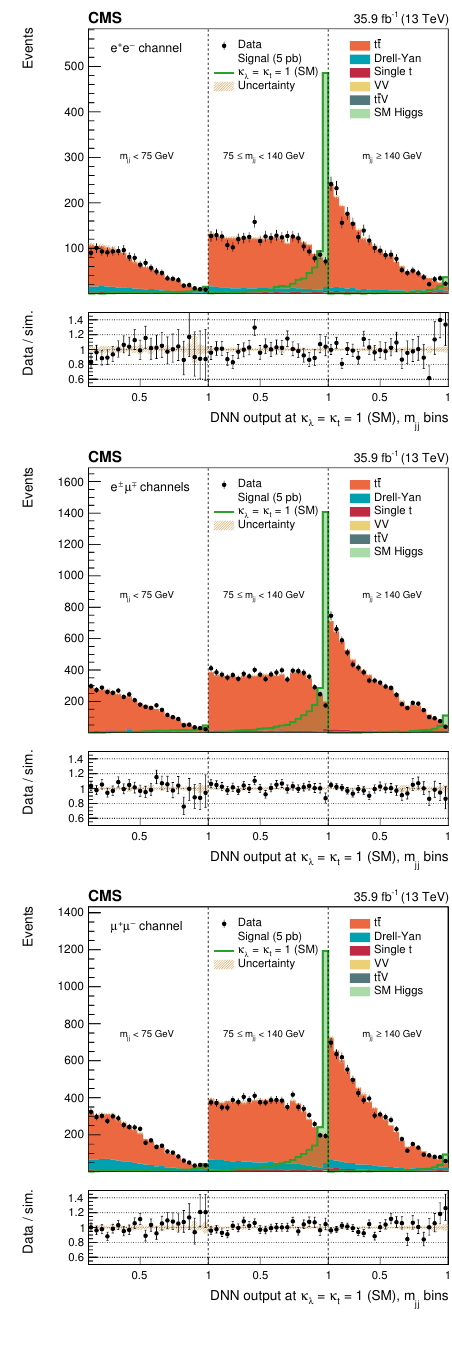
Figure 6 . The DNN output distributions in data and simulated events, for the e + e (cid:0) (top), e (cid:6) (cid:22) (cid:7) (middle), and (cid:22) + (cid:22) (cid:0) (bottom) channels, in three di(cid:11)erent m jj regions: m jj < 75 GeV, m jj 2 [ 75 ; 140 ) GeV, and m jj (cid:21) 140 GeV. The parameterised resonant DNN output (left) is evaluated at m X = 400 GeV and the parameterised nonresonant DNN output (right) is evaluated at (cid:20) (cid:21) = 1, (cid:20) t = 1. The two signal hypotheses displayed have been scaled to a cross section of 5 pb for display purposes. Error bars indicate statistical uncertainties, while shaded bands show post-(cid:12)t systematic